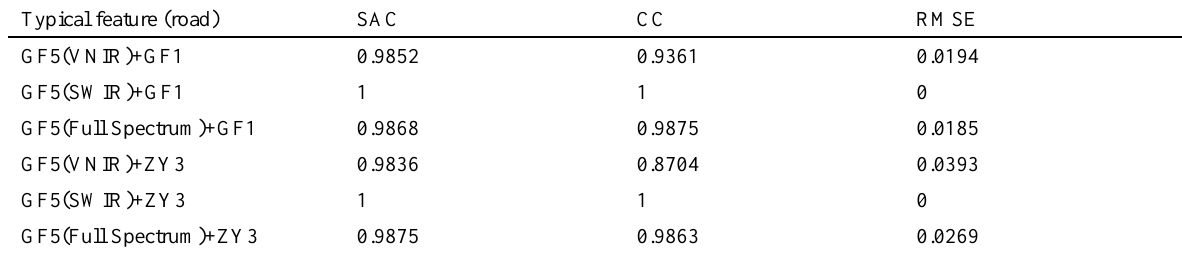
Table 6 . Spectral quality evaluation after